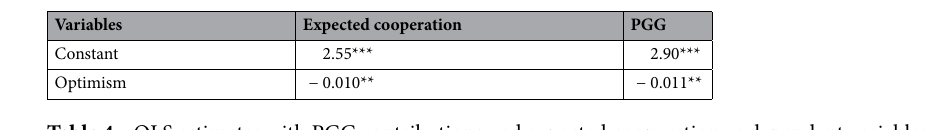
Table 4. OLS estimates with PGG contributions and expected cooperation as dependent variables and optimism and a constant as regressors. **p < 0.01, ***p <